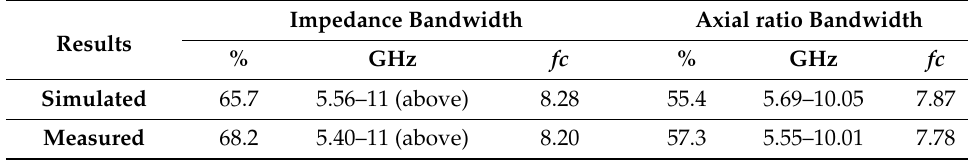
Table 6. Comparison of quad port results.